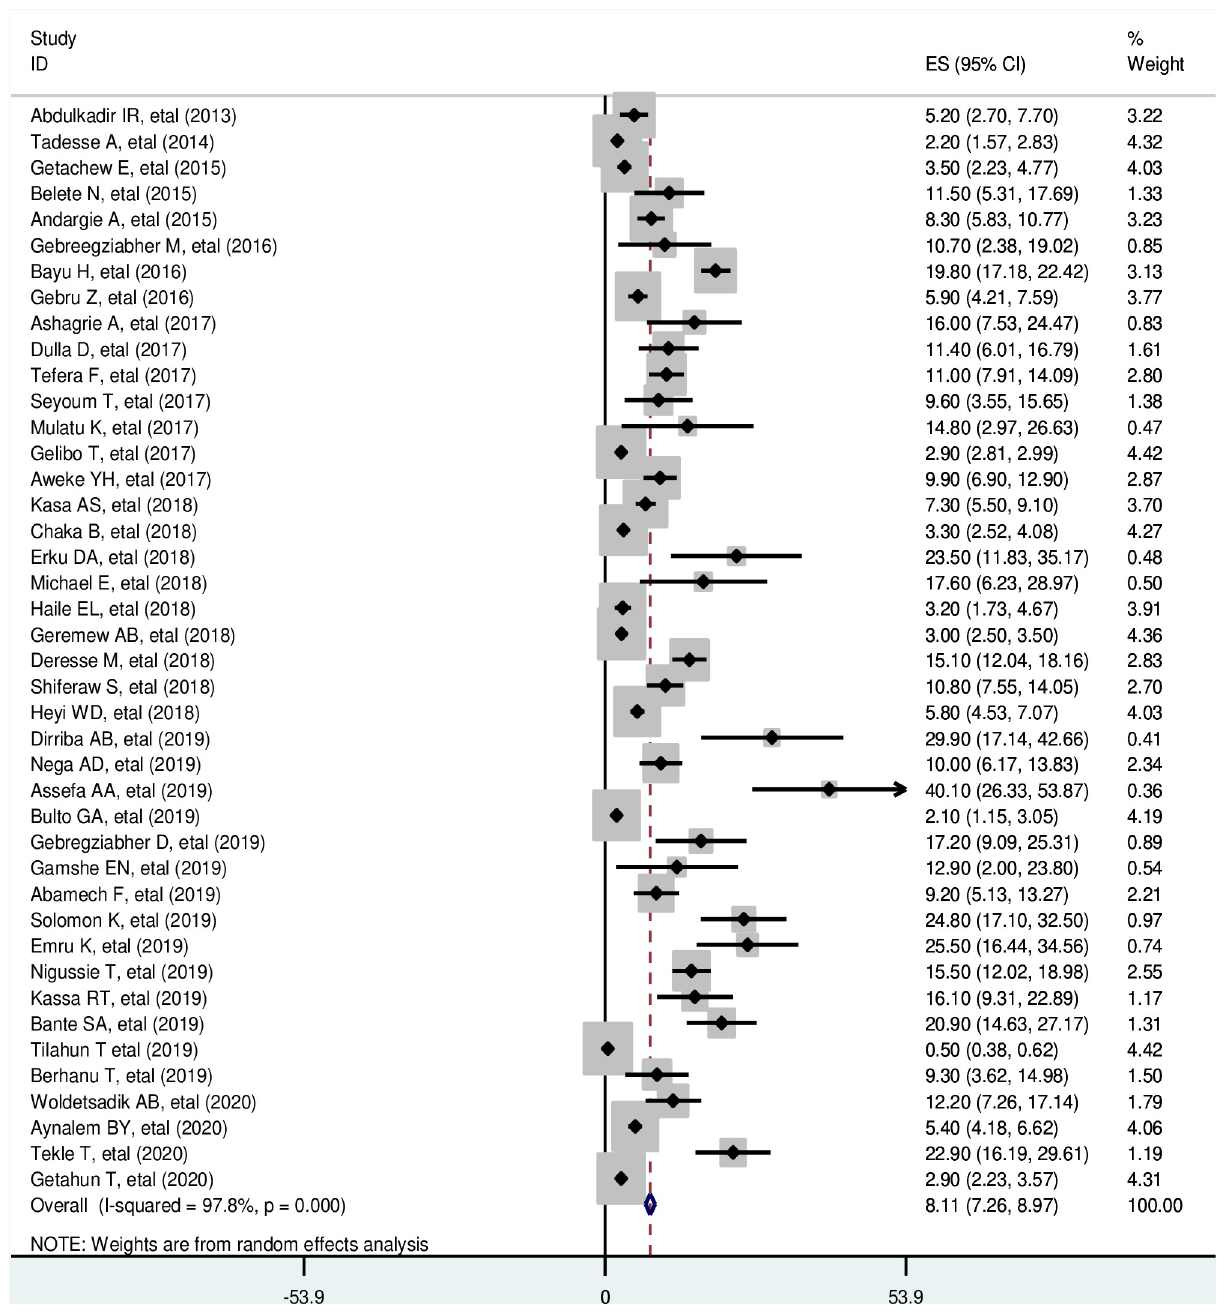
Fig 2. Forest plot for the prevalence of cervical cancer screening service